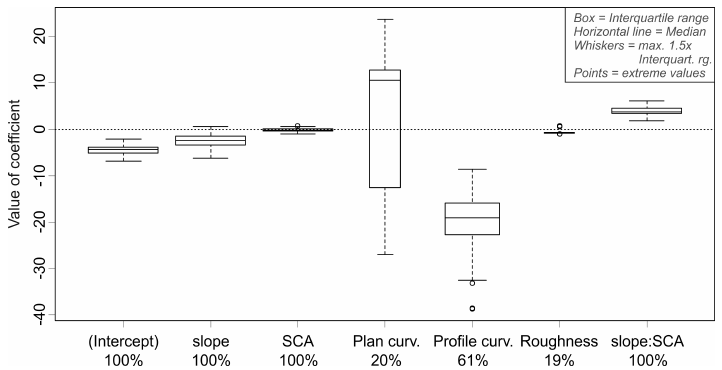
Fig. 5. Distributions of model coefficients estimated from 100 random samples ( n =350 non-event cells) in the ZBT area. The percentages below the parameter name refer to the proportion of the 100 models that contain the respective geofactor.